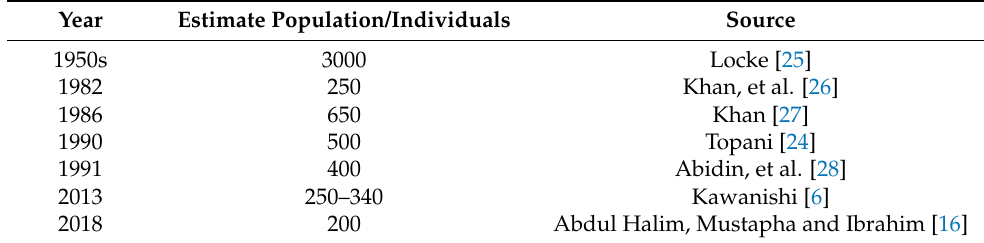
Table 1. Estimated wild Malayan Tiger population in Malaysia.